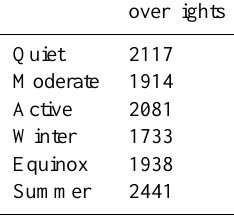
Fig. 9. Relative error between 1D SECS and EISCAT α as a function of distance between the satellite and the radar for all five CHAMP overflights passing close to EISCAT with data from the radar available. From left to right, the times of the overflights are: 20/11/2001